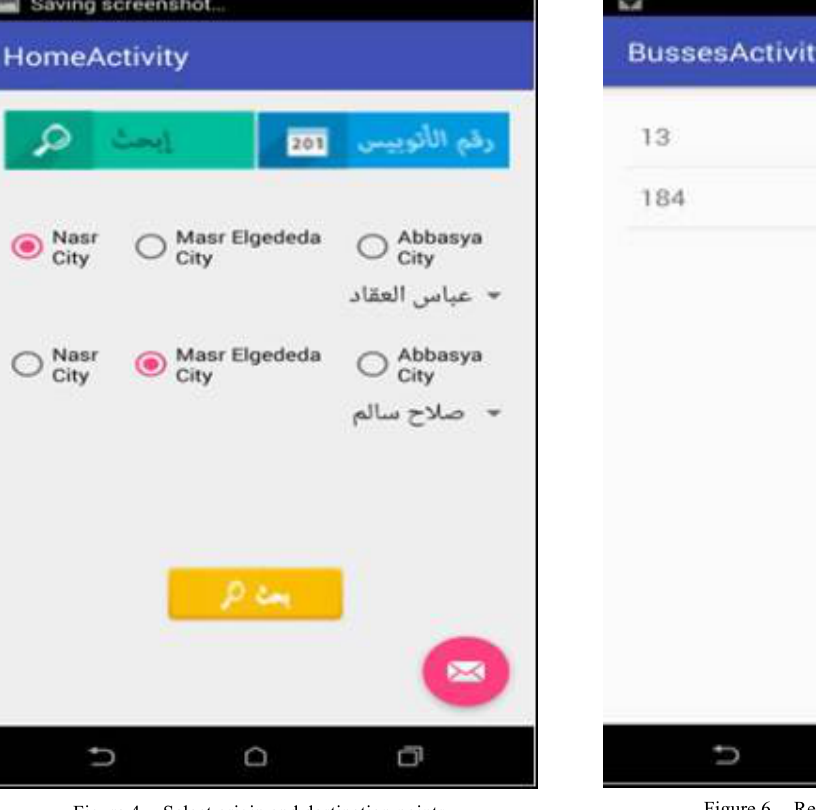
Figure 4. Select origin and destination points